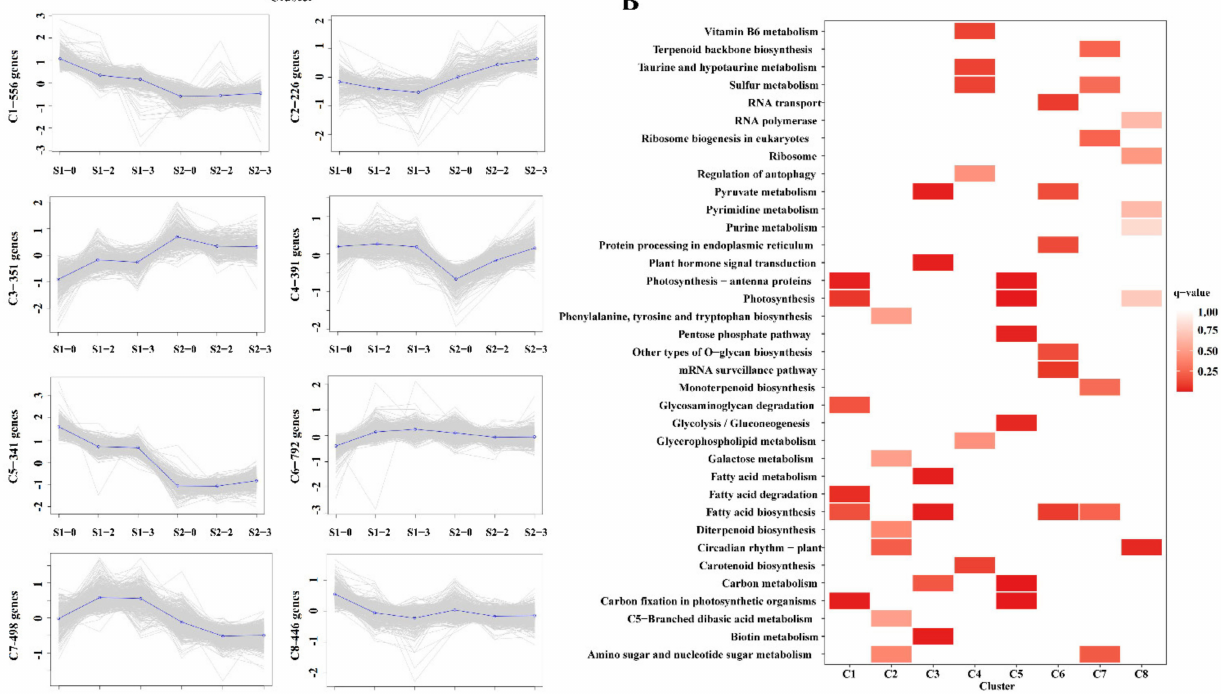
(Figure S2A,B). KEGG pathways enriched in S2-2 vs. S2-0 and S2-3 vs. S2-0 were mainly